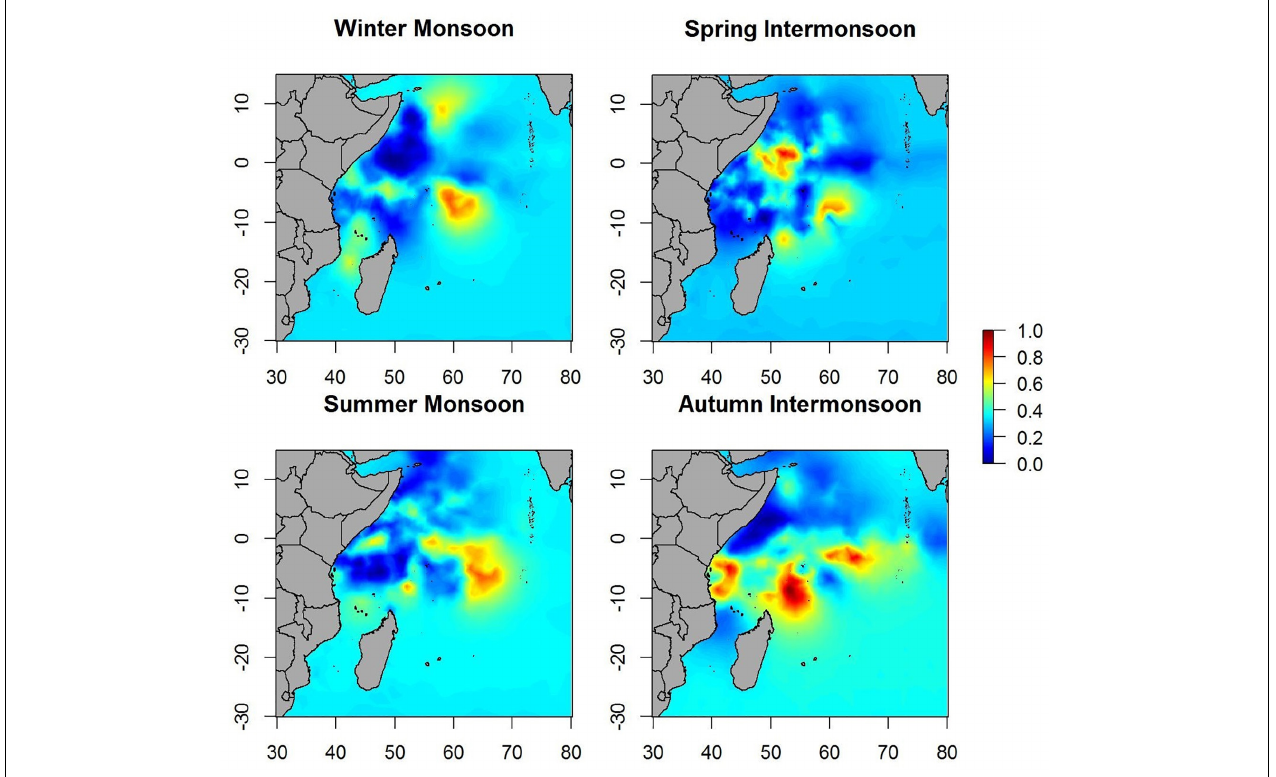
FIGURE 3 | Maps of the posterior mean of tuna occurrence probability in different